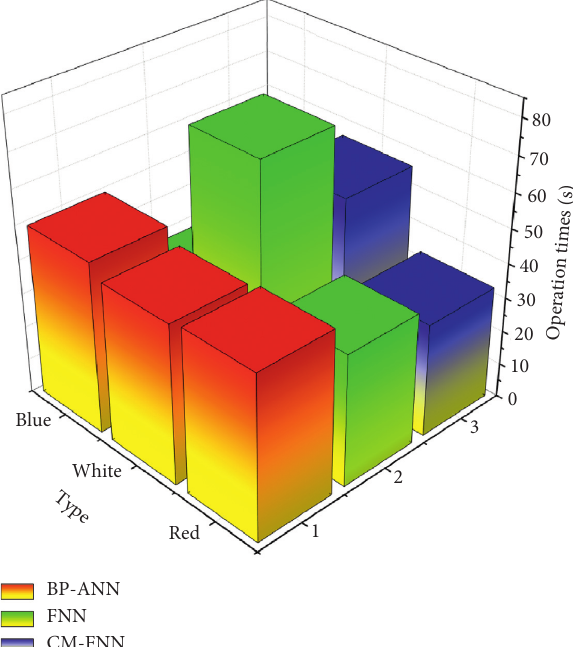
Figure 4: Comparison of algorithm running times for datasets.